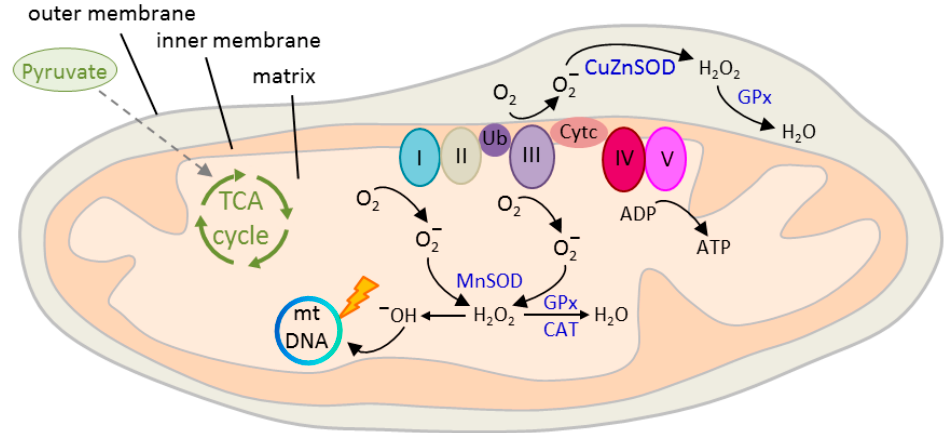
Figure 3. Structure and function of the mitochondrion. Outer and inner double-layered membranes enclose the intermembrane space, the cristae space formed by infoldings of the inner membrane, and the matrix as the space within the inner membrane. The matrix hosts the circular mitochondrial DNA (mtDNA) and a large number of enzymes catalyzing various biochemical reactions. Blood-borne glucose is metabolized intracellularly to pyruvate and then to acetyl-CoA, the only substrate fueling the tricarboxylic acid (TCA) cycle. Oxidation of pyruvate produces reduced cofactors that transfer free electrons to the electron transport chain (ETC) hosted at the inner mitochondrial membrane. The ETC consists of complex I to V that build an electrochemical gradient ( ∆ ϕ m ) across the inner mitochondrial membrane driving the synthesis of adenosine triphosphate (ATP). Electron leakage mainly at complex I and III (0.1 to 2%) reduces prematurely oxygen to superoxide anion (O 2 − ) that is converted by mitochondrial superoxide dismutase MnSOD and CuZnSOD to hydrogen peroxide (H 2 O 2 ) in the matrix or intermembrane space, respectively. Thereafter, H 2 O 2 is oxidized to highly reactive hydroxyl (OH − ) free radicals that cause mtDNA damage, reduced transcription, and oxidation of ETC proteins and membrane lipids. Radical production is counteracted by enzymatic defense mechanisms, including glutathione peroxidase (GPx) and catalase (CAT) that detoxify H 2 O 2 into water. Ub = ubiquinone, also known as Coenzyme Q10; Cyt c = cytochrome